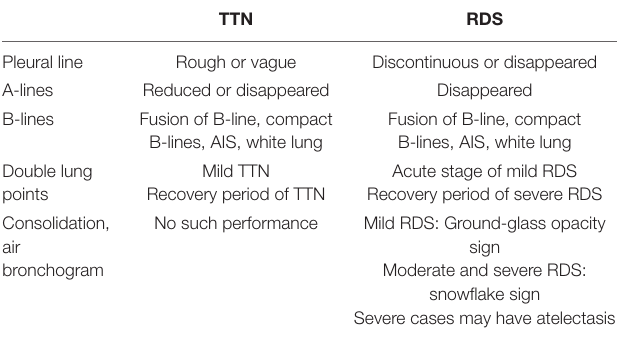
TABLE 1 | Differences of the ultrasonic images between TTN and RDS.